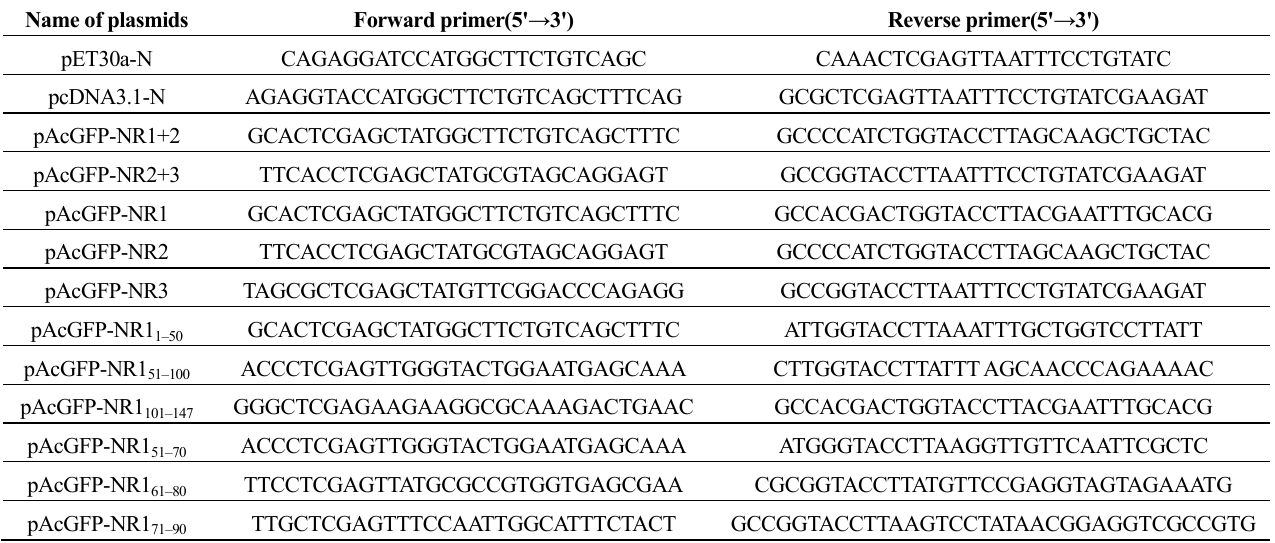
Table 1. Primers for constructing recombinant